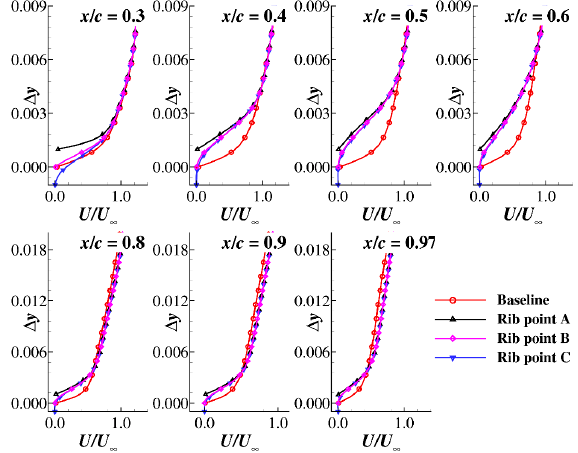
Figure 14. Wall-parallel velocity profiles at the seven streamwise locations.